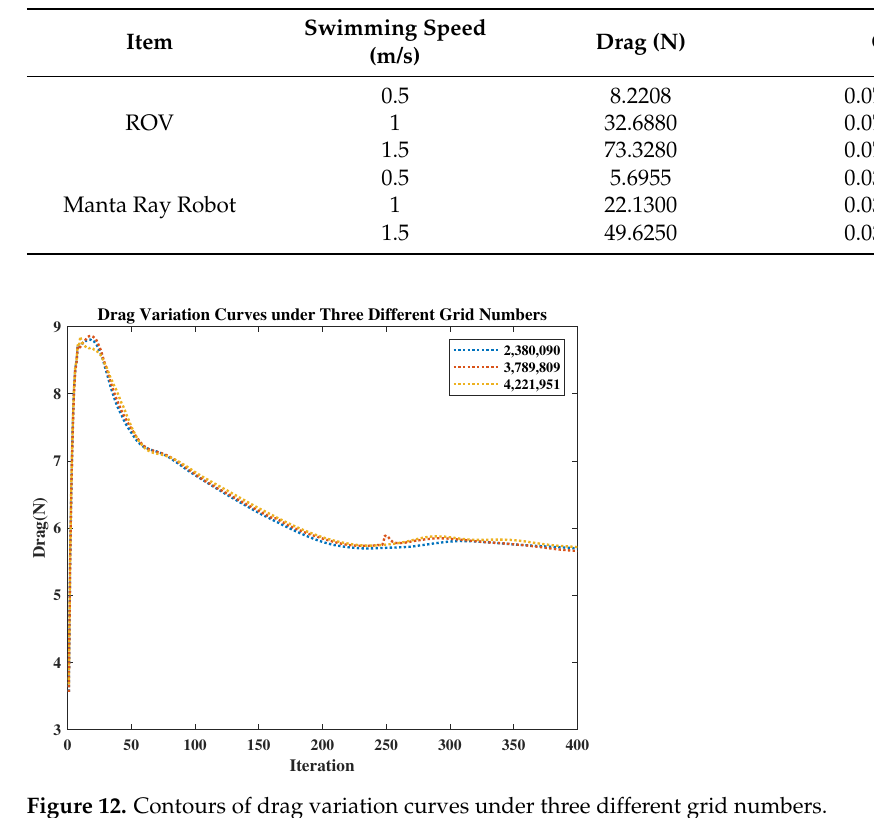
Figure 12. Contours of drag variation curves under three different grid numbers.